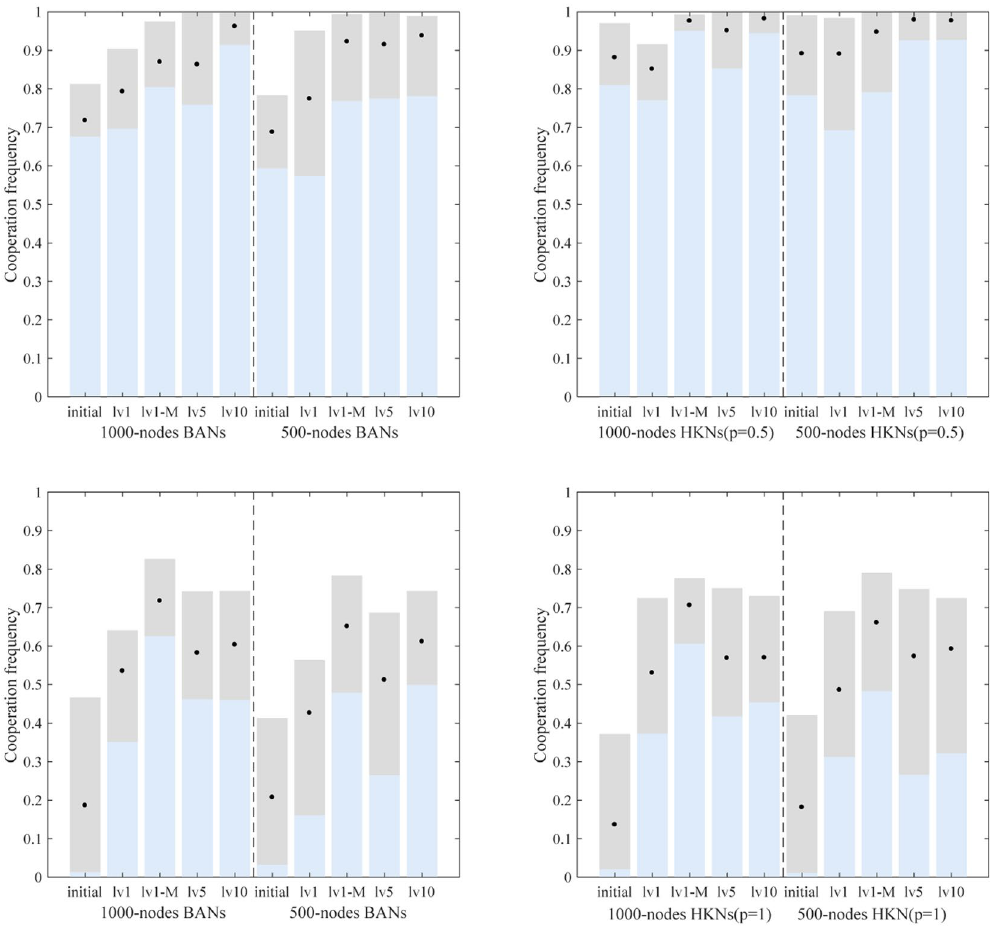
Figure 6. Simulation results of lv1, lv1-M, lv5 and lv10 in optimizing population structure for the promotion of cooperation in PDG. Each group contains 10 independent structures whose evaluated cooperation level lies within a gray bar (black points mark the mean value). The results in the upper (bottom) row are obtained under the Fermi rule (unconditional imitation rule). Overall, these algorithms all effectively promote cooperation in PDG. mlEA-C PD -SFN 10 performs best under the Fermi rule, while mlEA-C PD -SFN 1 -M performs best under the unconditional imitation rule.